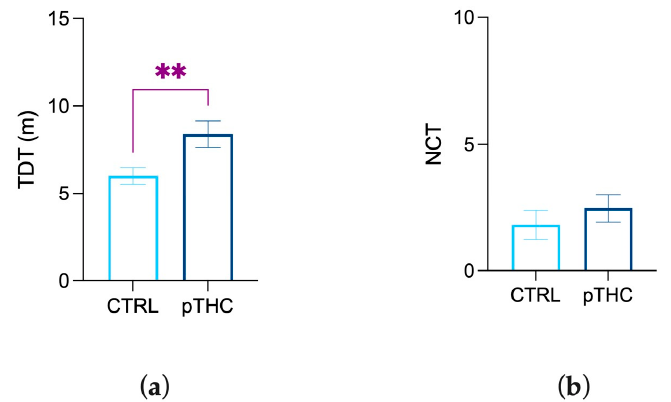
Figure 2. Effects of prenatal TCH exposure (2 mg/kg) on locomotor activity and exploration of the adolescent male rat offspring in the OFT: ( a ) Prenatal exposure to THC increased locomotor activity in terms of TDT while ( b ) induced no significant effects in exploratory activity in terms of NCT. Each bar represents the mean of n = 12 rats; error bars indicate SEM. ** p < 0.01; CTRL = male rat offspring prenatally exposed to Veh; pTHC = male rat offspring prenatally exposed to THC; TDT = total distance travelled; NCT = the number of central transitions from the peripheral to the central area of the arena.